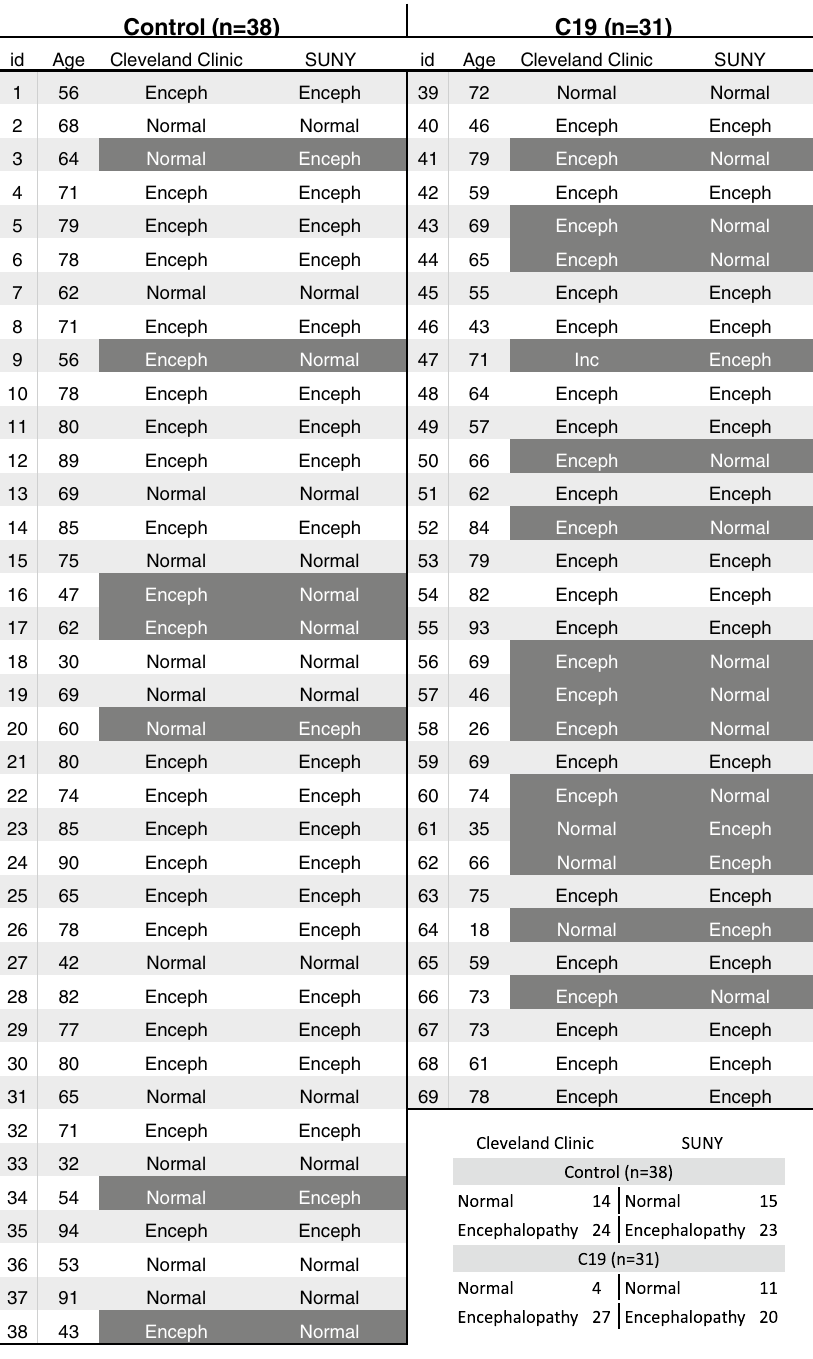
Table 1. Qualitative assessment of EEG by two independent teams at Cleveland Clinic and SUNY for the diagnosis of encephalopathy (n = 38 control, n = 31